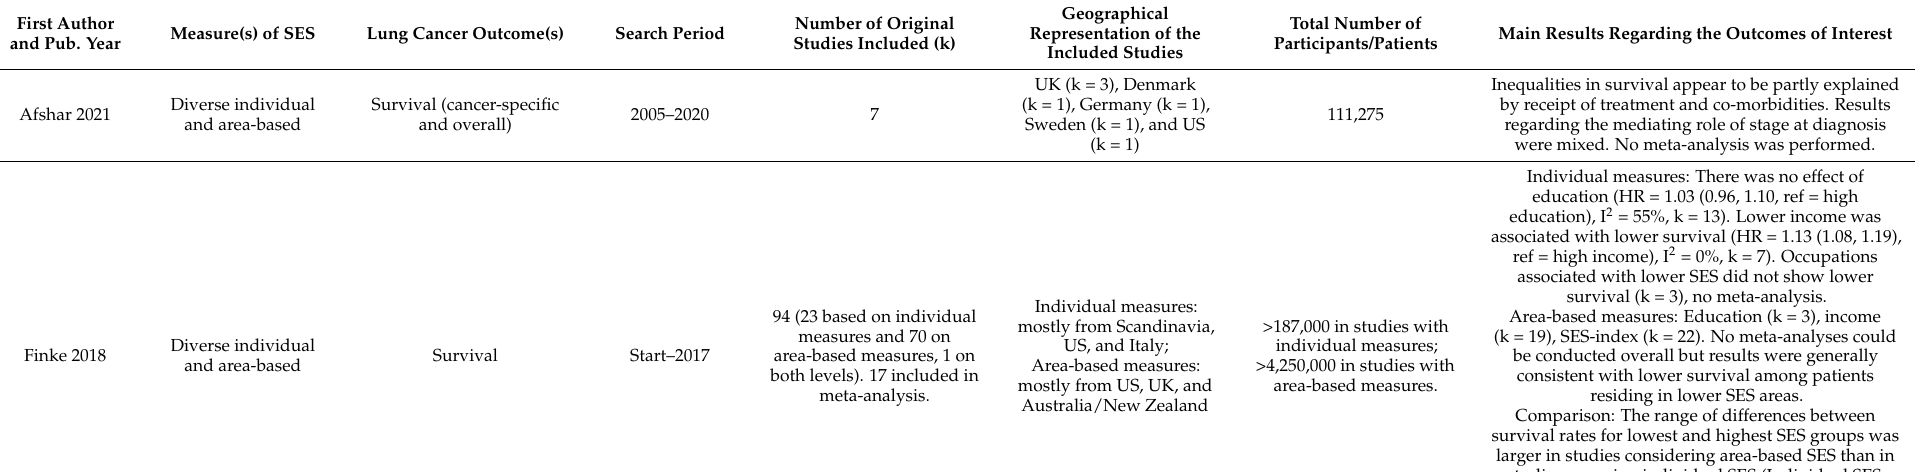
Table 1. Main characteristics and results of the included